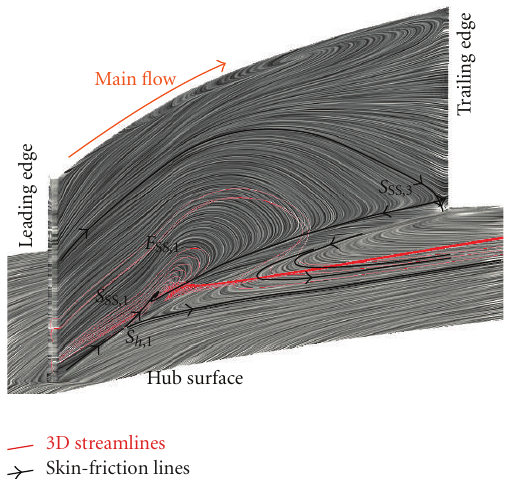
Figure 13: Evidence of a boundary-layer separation time-averaged flow field; operating point D.